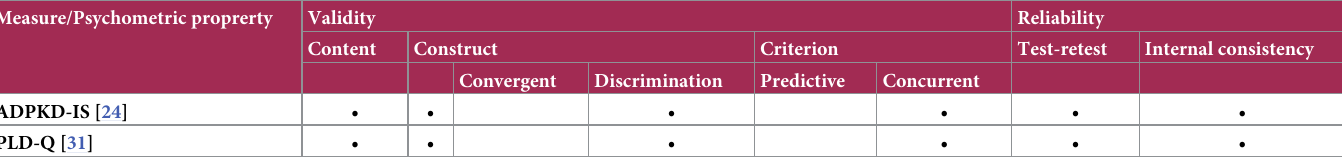
Table 5. Development/validation data on psychometric